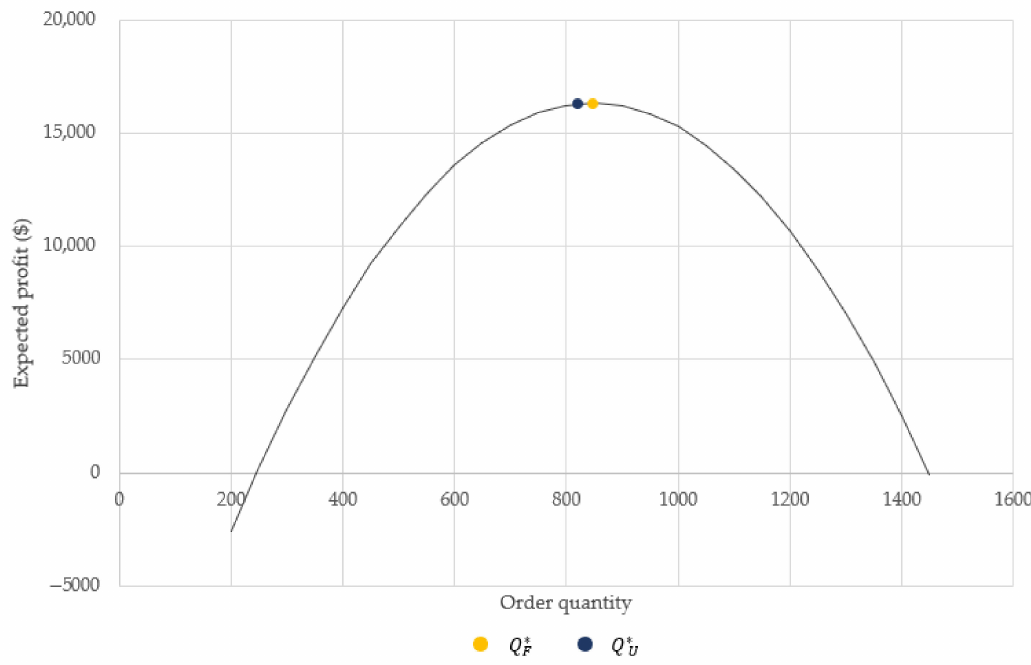
Figure 2. Expected